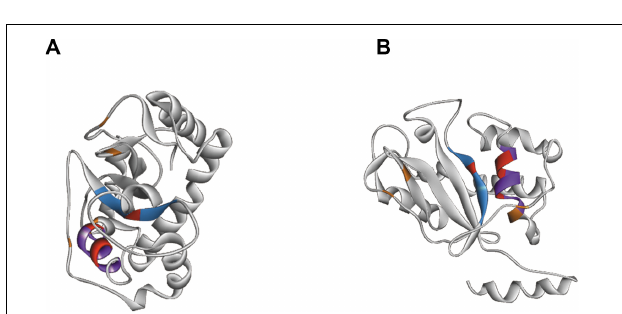
FIGURE 4 | Structure of RNAse T2 from Tupanvirus Soda Lake . Panels (A,B) shows the RNase T2 with two different views. The active site is marked by CAS I domain in blue and CAS II domain in purple. The important amino acids of the active site are showed in red and stabilizing cysteines in